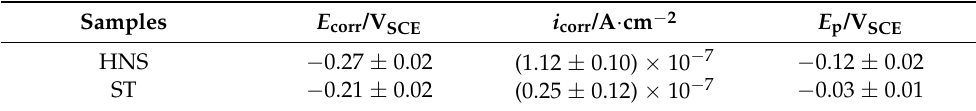
Figure 4. Potentiodynamic polarization curves for HNS and ST in 3.5% NaCl solution. Table 1. Fitting results of the polarization curves for HNS and